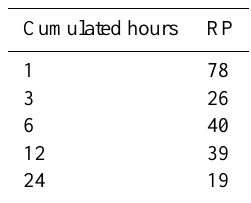
Table 7. Estimated return period (RP) in years for rainfall accumu- lated in 1, 3, 6, 12 and 24h during the 1 October 2009